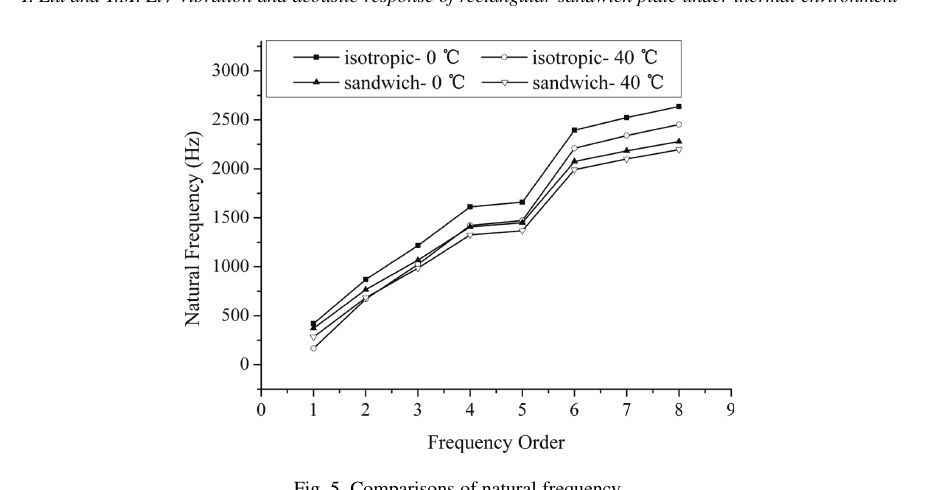
Fig. 5. Comparisons of natural frequency.